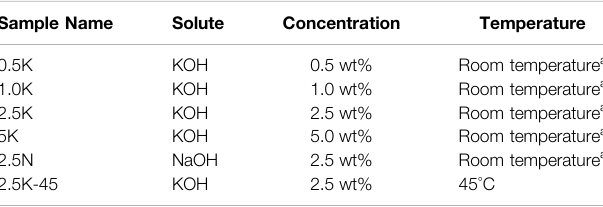
TABLE 1 | Alkaline pretreatment conditions on silicone elastomers for cross-MPC copolymer